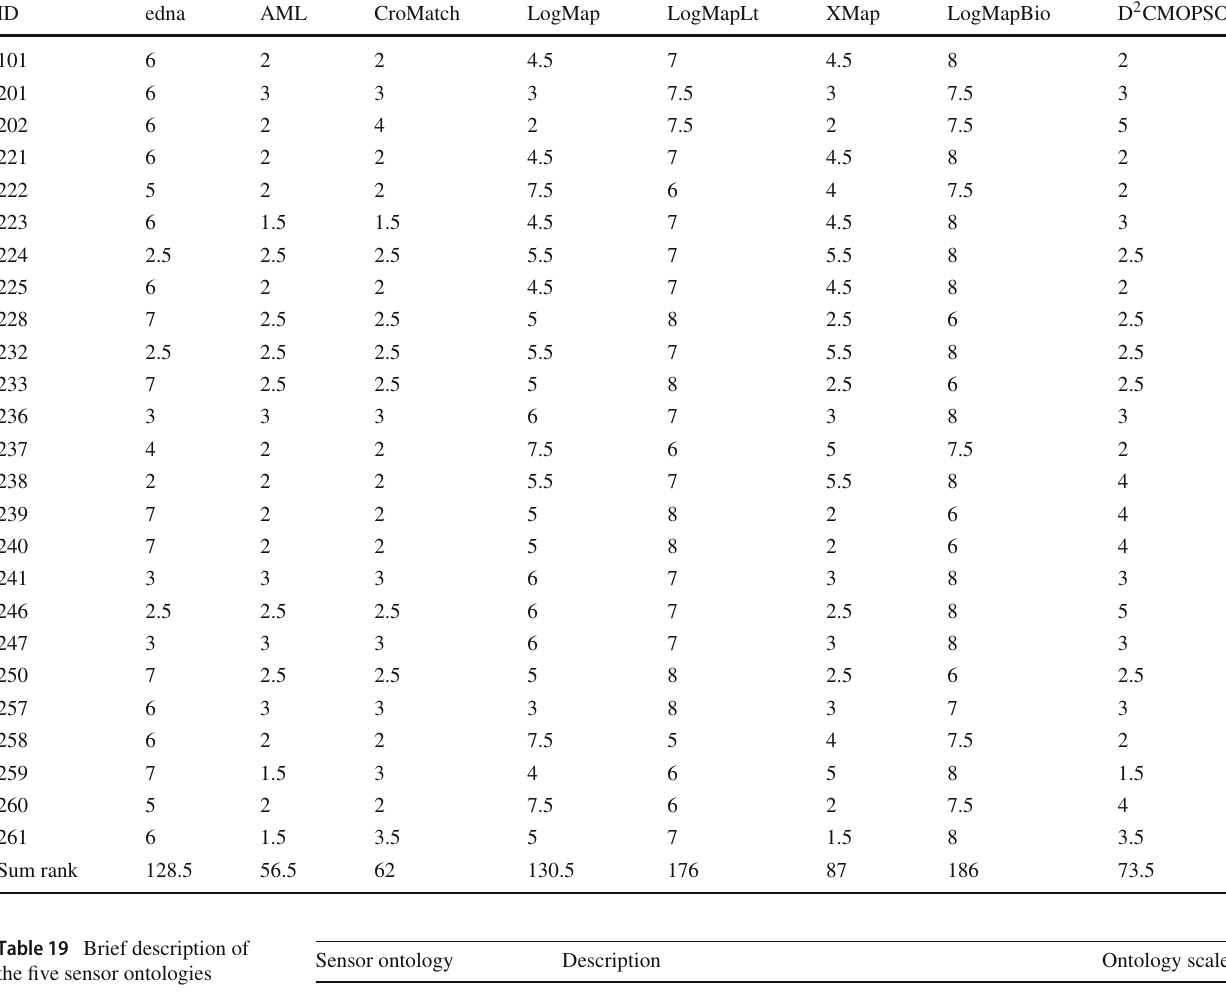
Table 18 Friedman test for precision between D 2 CMOPSO and OAEI’s participants in benchmark track